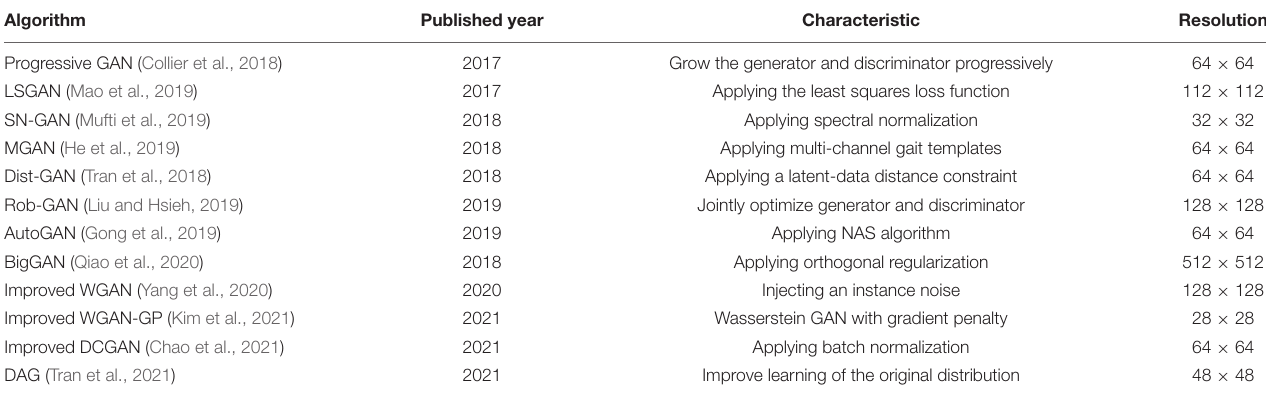
FIGURE 1 | The results of testing tea chrysanthemum – generative adversarial network (TC-GAN) on NVIDIA Jetson TX2. First, we used an HDMI cable to connect the laptop with the Jetson TX2, and ensure that the laptop and Jetson TX2 were under the same wireless network. Then, the TC-YOLO model and the tea chrysanthemum dataset were embedded in the flashed Jetson TX2 for testing. TABLE 1 | Details of the twelve latest generative adversarial